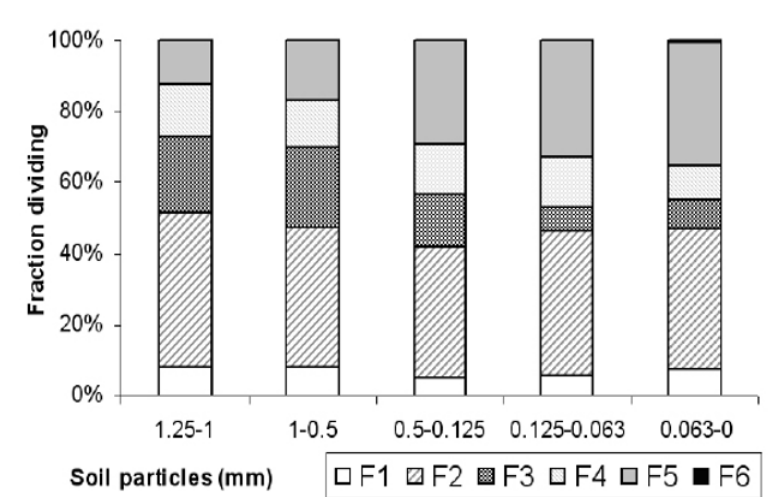
Figure 1. Mercury forms distribution of Nar 2 subsamples.